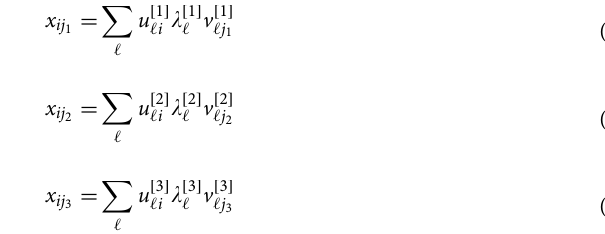
∈ R 33538 × M [ c ] 6 , 1 ≤ c ≤ 25 , representing ij [ c ] 6